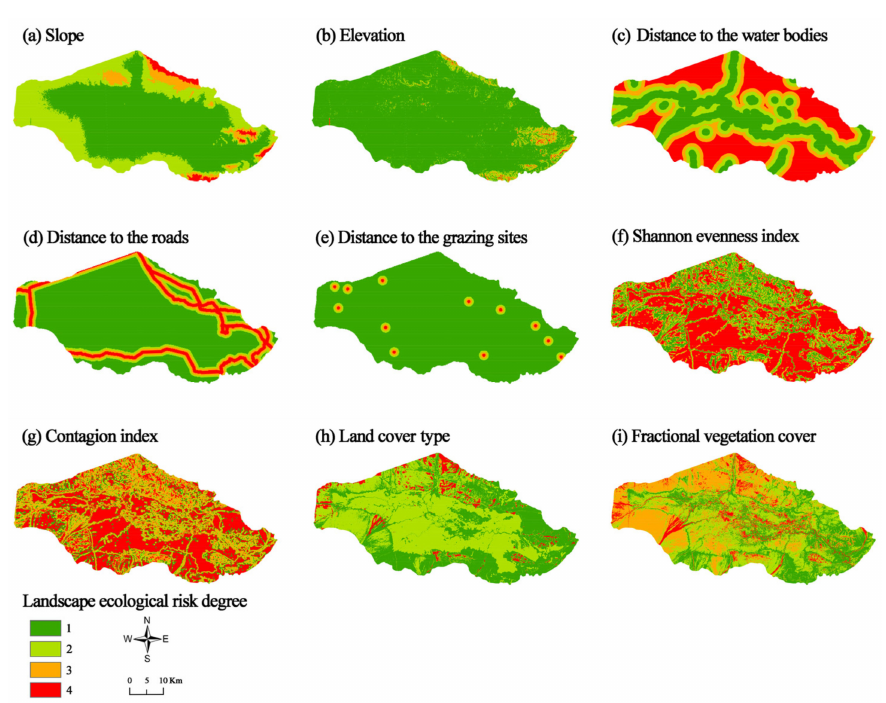
Figure 4. Degree of landscape ecological risk for each